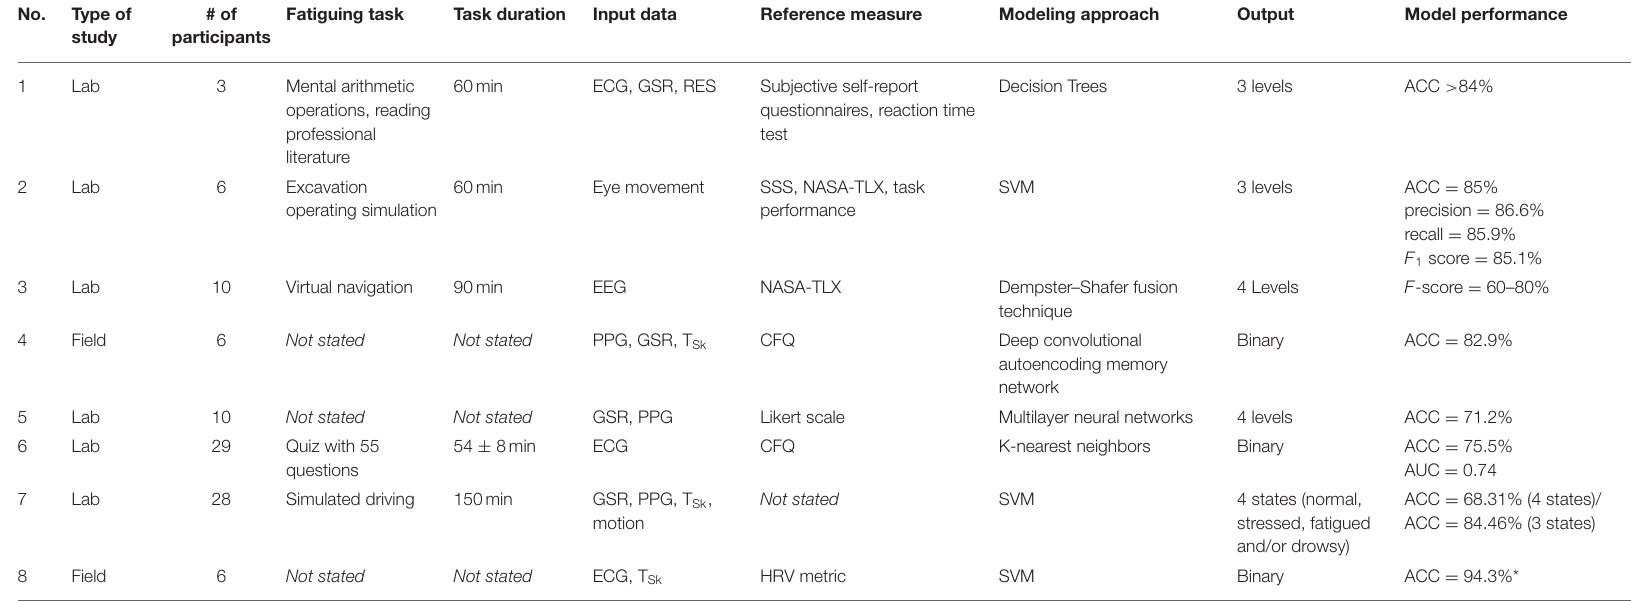
ECG, electroencephalogram; EEG, electroencephalogram; GSR, galvanic skin response; PPG, photoplethysmogram; RES, respiration; T Sk , skin temperature; CFQ, the Chalder fatigue scale; HRV, heart rate variability; NASA-TLX, NASA task load index; SSS, Stanford sleepiness scale; SVM, support vector machine; ACC, accuracy; AUC, area under the receiver operating characteristic curve. * Calculated average of classes (97.2% for alert, and 91.3% for fatigued